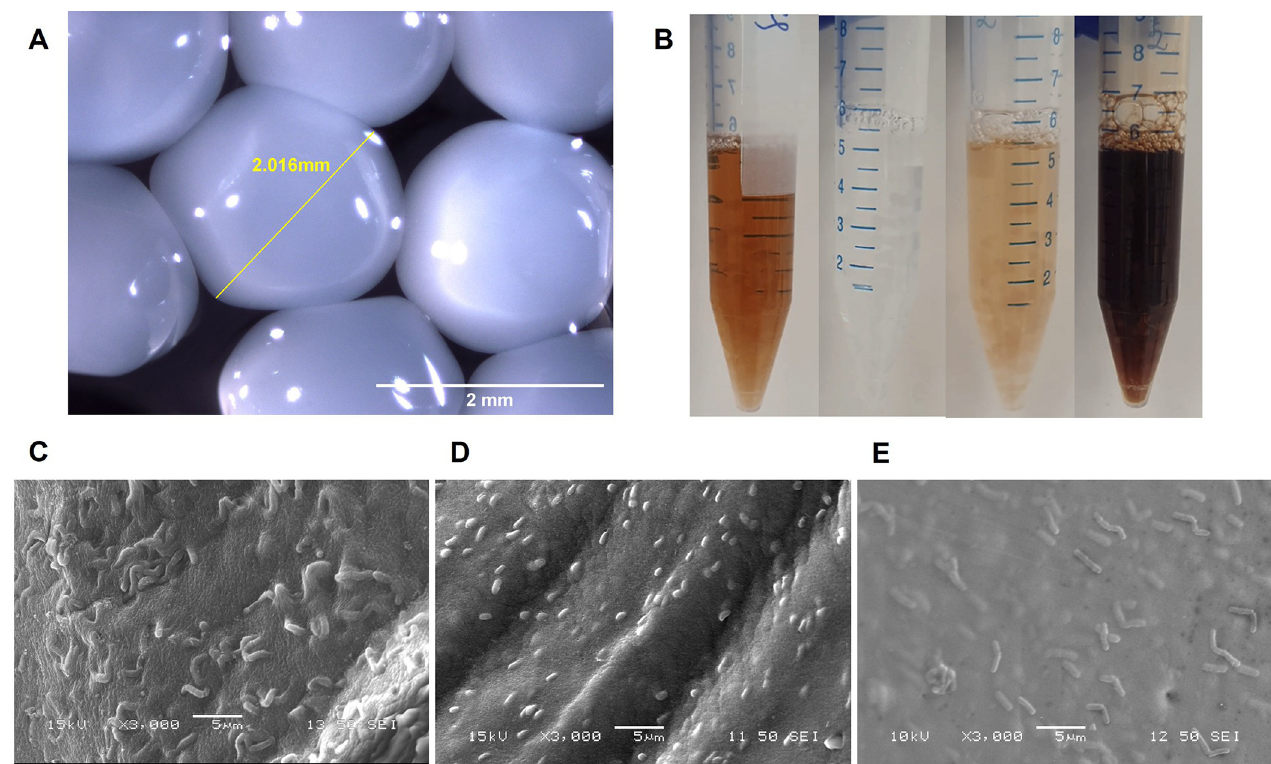
Fig 3. Images of alginate–encapsulated probiotic beads. (a) Light microscope images of alginate–encapsulated beads; (b) Alginate–probiotic beads added to various beverages, from left to right, Coke, 7–Up, Tiger Beer, and Guinness; SEM images of (c) LGG, (d) ECN, and (e) BL embedded within calcium–alginate